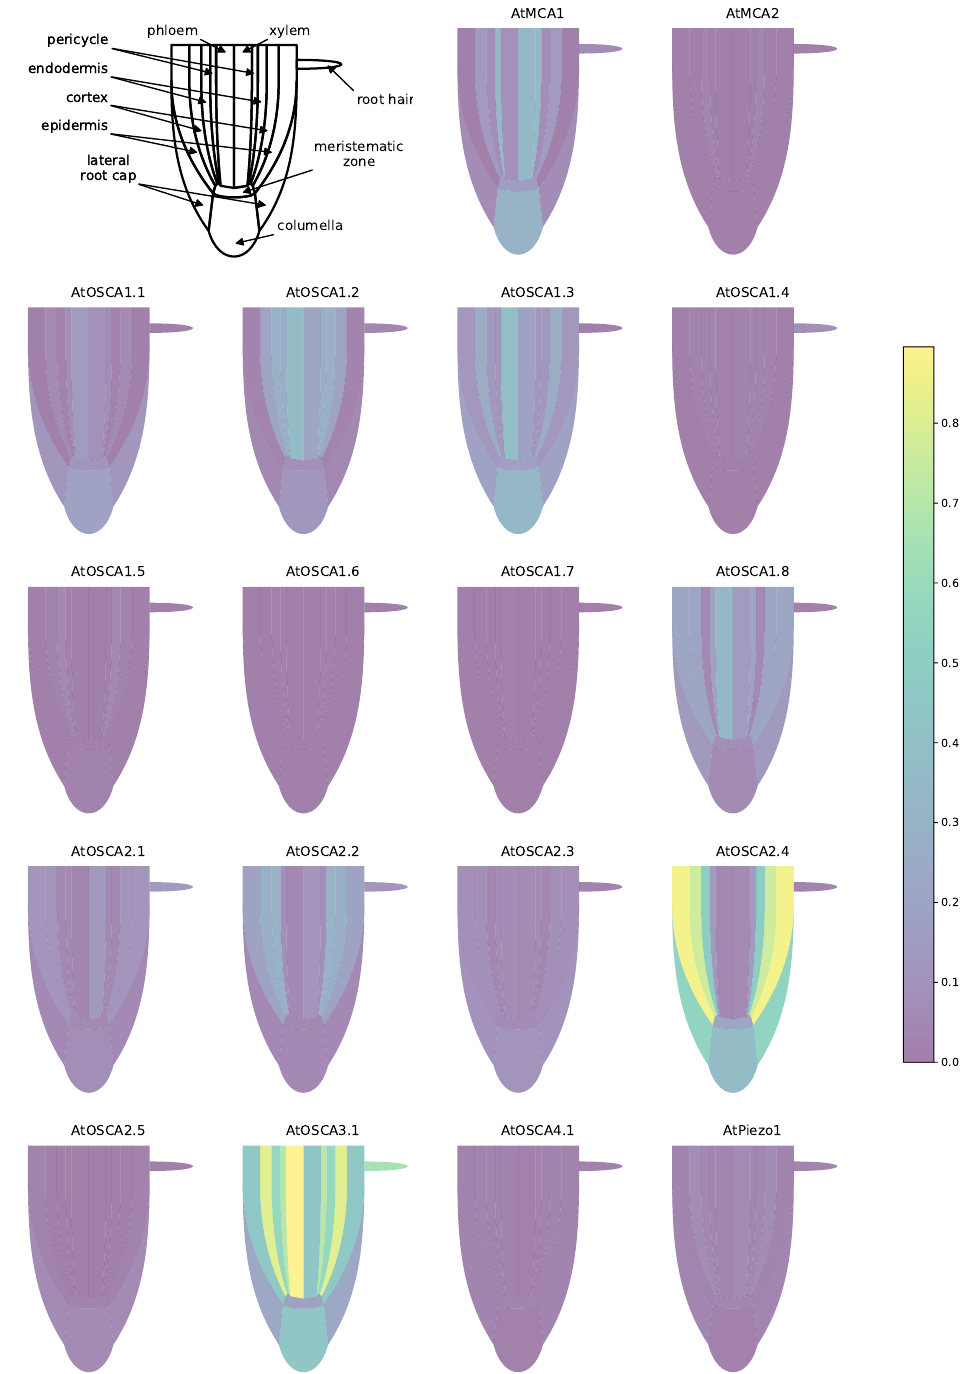
Figure A1. Expression patterns of MCA , Piezo and OSCA genes in different tissues of the Arabidopsis root using a common scale. Unlike Figure 4, which shows an individual scale for each gene, this figure allows comparisons between expression levels of different